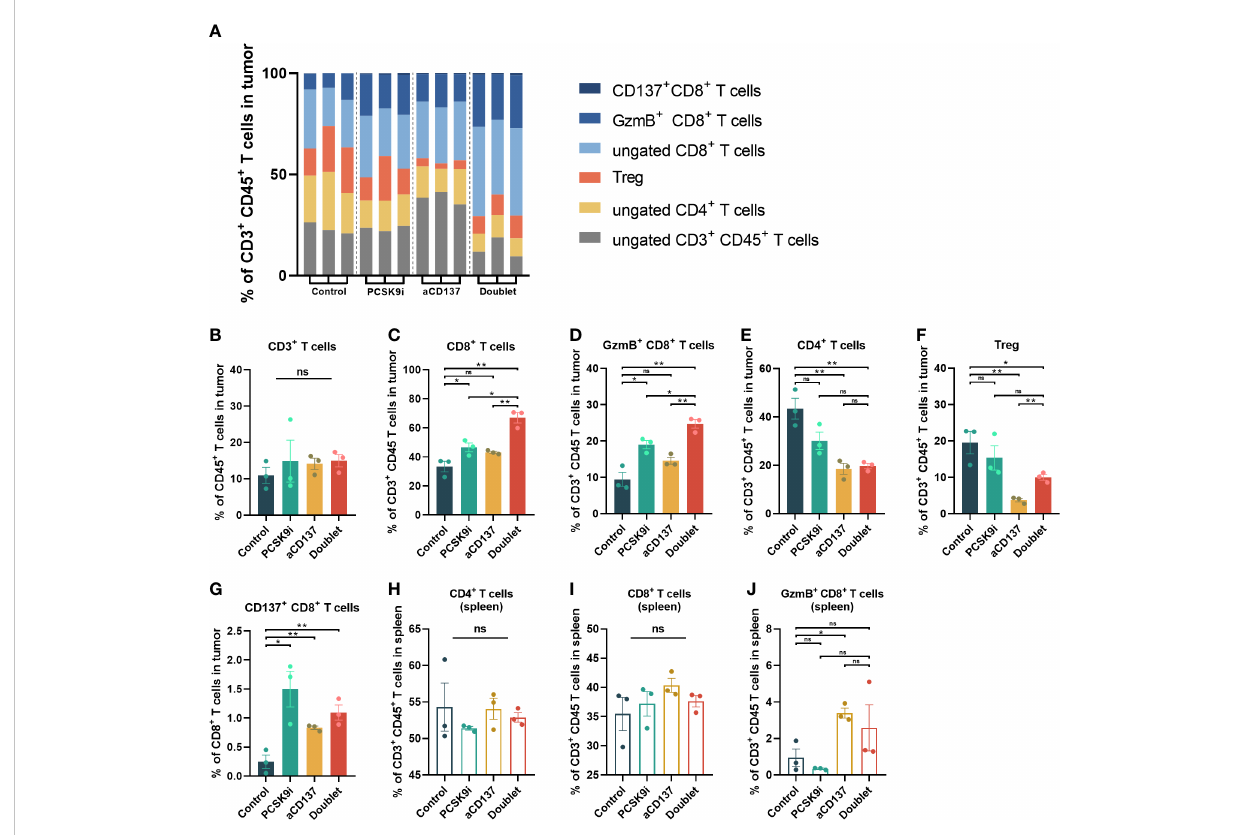
FIGURE 5 The proportion of CD8 + and GzmB + CD8 + T cells increased signi fi cantly in the tumors of the doublet group with a reduction of Tregs. (A) Frequency of tumor-in fi ltrating CD4 + and CD8 + T cells of CD3 + CD45 + leukocytes in LLC tumors of each group on day 21 ( n = 3 per group). (B – G) Quantitative estimate of various immune effector cells in 1 * 10 6 immune cells of tissue in each group determined by fl ow cytometry. n = 3 tumors per group ( P - value was calculated by unpaired t -test or the Mann – Whitney test). (H – J) Quantitative estimate of CD4 + , CD8 + , and GzmB + CD8 + T cells in 0.1 * 10 6 immune cells of the spleen in each group determined by fl ow cytometry. n = 3 tumors per group ( P -value was calculated by unpaired t -test or the Mann – Whitney test). *ns, No signi fi cant difference, * P < 0.05, ** P <